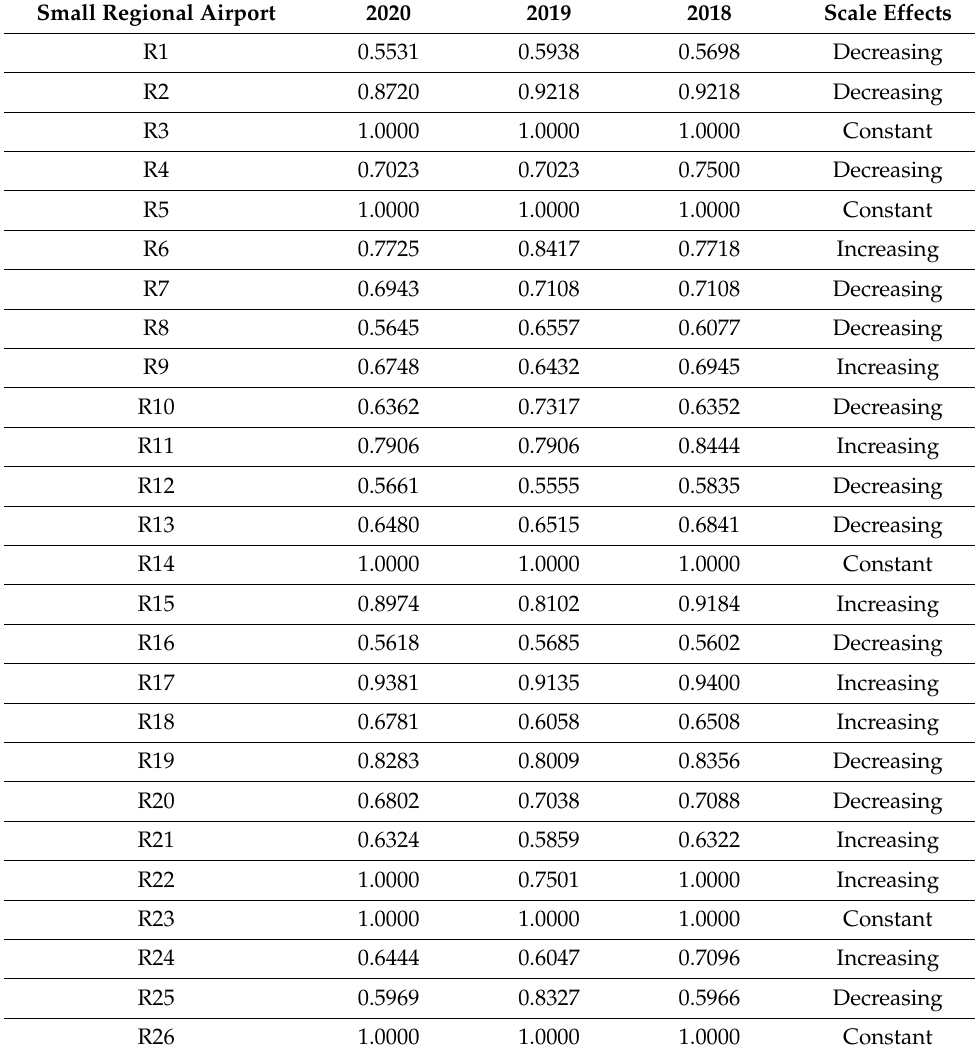
Table 2. Efficiency indices based on the BAM model for small regional airports in Colombia (2018, 2019, and 2020). Source: Authors’ own